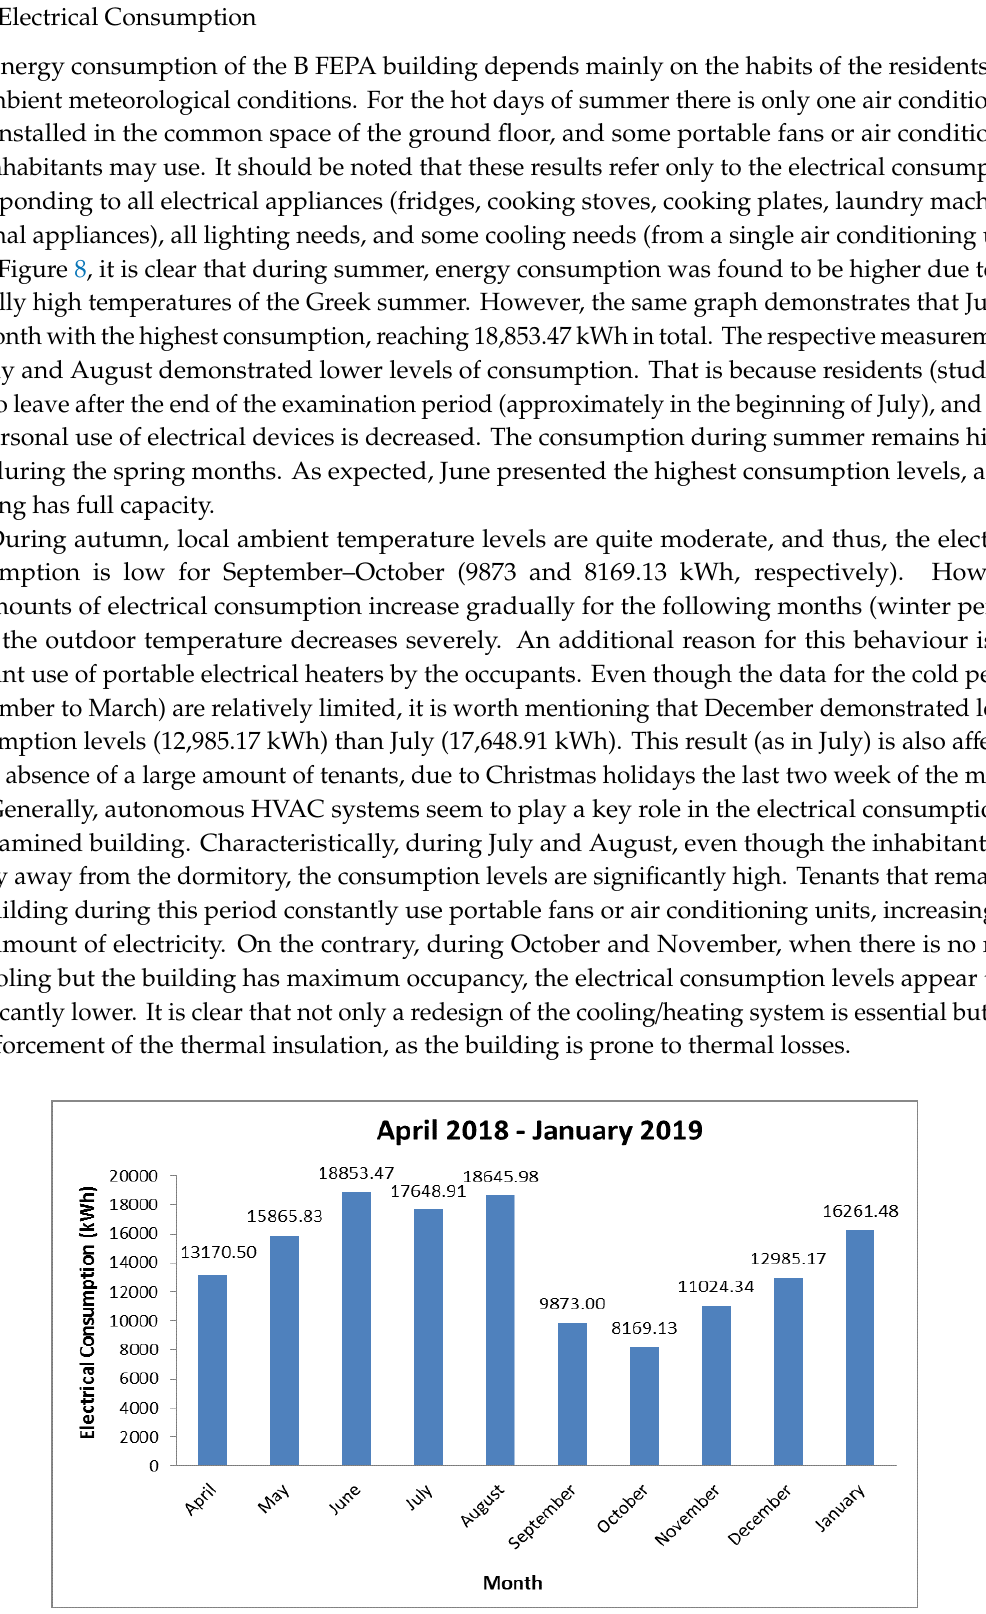
Figure 8. Monthly electrical consumption of B FEPA from April 2018 to January 2019.